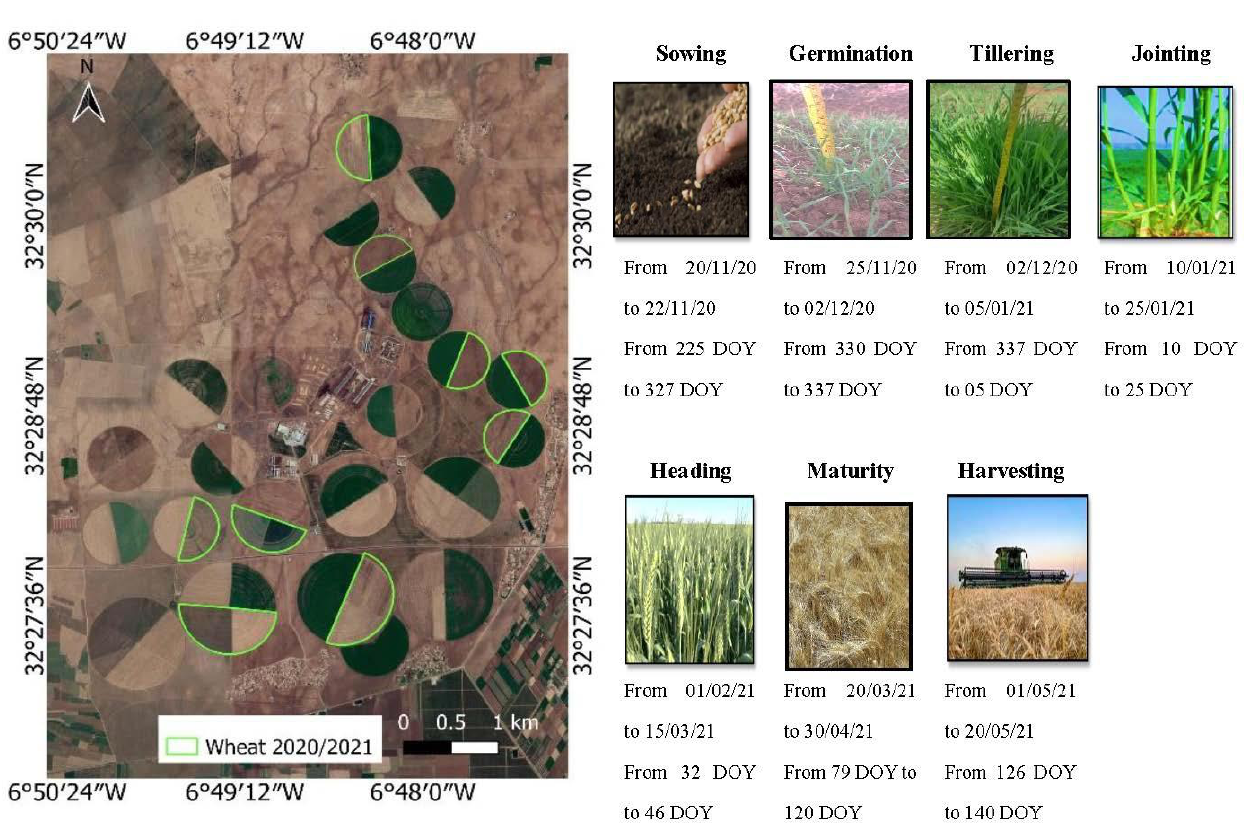
Figure 3. Location of durum wheat fields for the year 2020/2021 ( left ) and phenological stages calendar of wheat ( right ).